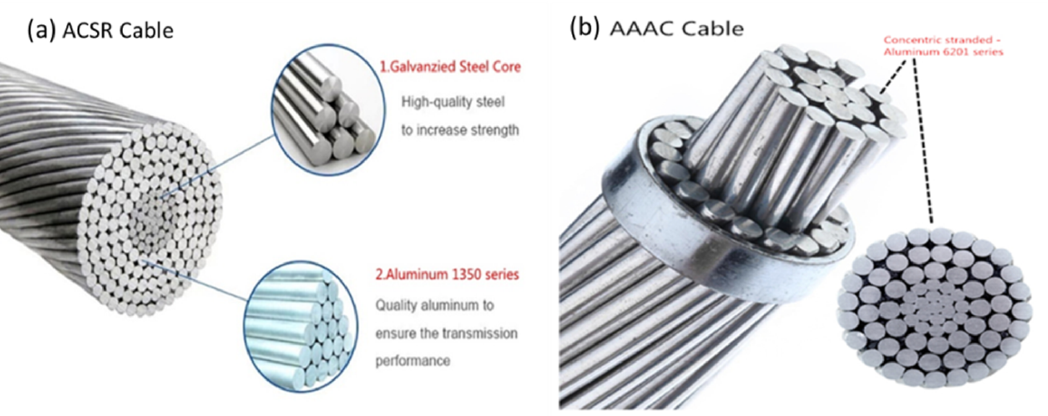
Figure 3. Conventional transmission conductors in the market: ( a ) ACSR and ( b ) AAAC [26].